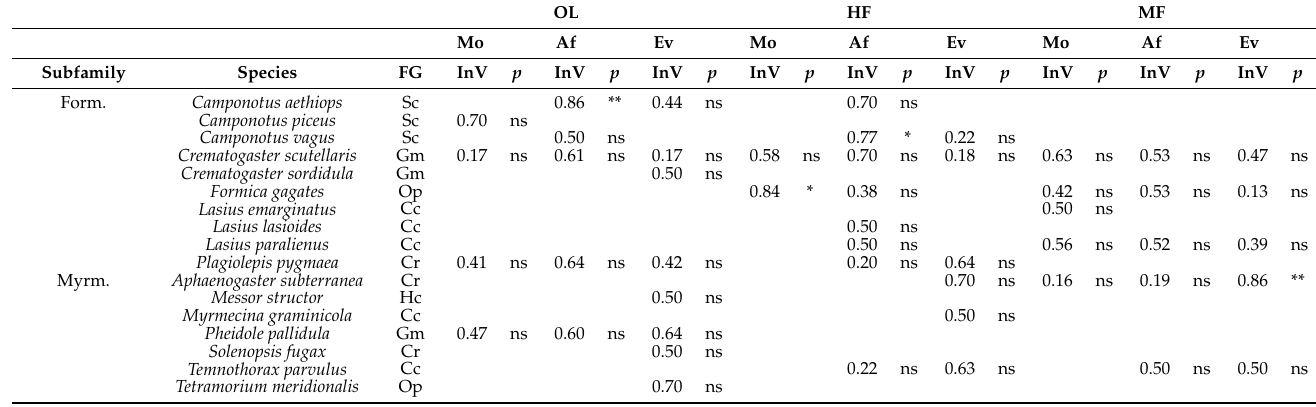
Figure 2. Non-Metric Multidimensional Scaling (nMDS) ordination plots for ( A ) pitfall traps (nMDS stress: 0.09), and ( B ) baits (nMDS stress 0.10). White symbols, olive plantation (OL); grey symbols, harvested forest (HF); black symbols, mature forest (MF). In ( A ), each symbol is a grid of pitfall traps, and circles and triangles represent the two different plots within each habitat. In ( B ), each symbol is a transect, and different symbols represent the three daily periods (squares, morning; diamonds, afternoon; triangles, evening). Table 2. Functional group (FG), IndVal index (InV), and its significance ( p ) of the species collected by baiting in three habitats. Mo = Morning; Af = afternoon; Ev = evening; Form. = Formicinae; Myrm. = Myrmicinae; Significance levels: ns, not significant; * < 0.05; ** < 0.01. Functional groups: cc, cold-climate specialist; cr, cryptic species; hc, hot-climate specialist; gm, generalized Myrmicinae, op, opportunist; sc, subordinate